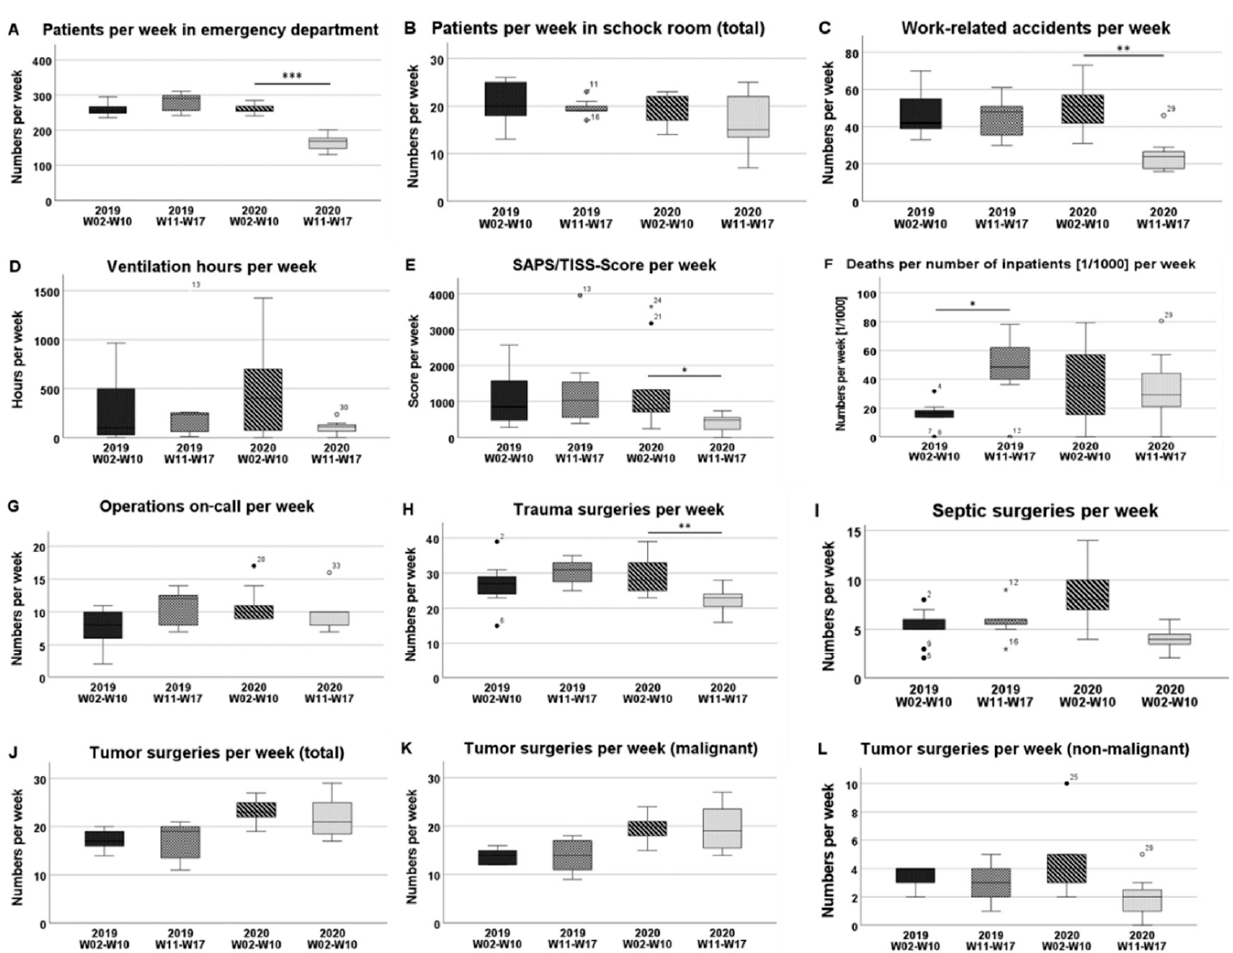
Figure 2. Comparison of the time phases in 2019 and 2020. The boxplots represent the investigated parameters in weeks 02–10 and in weeks 11–17 in 2019 and in 2020. The significance levels are defined as * p < 0.05, ** p < 0.01, and *** p < 0.001. ( A ) Patient numbers per week in the emergency department; ( B ) Patient numbers per week in the shock room; ( C ) Work- related accidents per week; ( D ) Ventilation hours per week; ( E ) SAPS/TISS-Score per week; ( F ) Deaths per number of inpatients (1/1000) per week; ( G ) Operations on-call per week; ( H ) Trauma surgeries per week; ( I ) Septic surgeries per week; ( J ) Musculoskeletal tumor surgeries in total per week; ( K ) Malignant or uncertain musculoskeletal tumor surgeries per week; ( L ) Non-malignant musculoskeletal tumor surgeries per